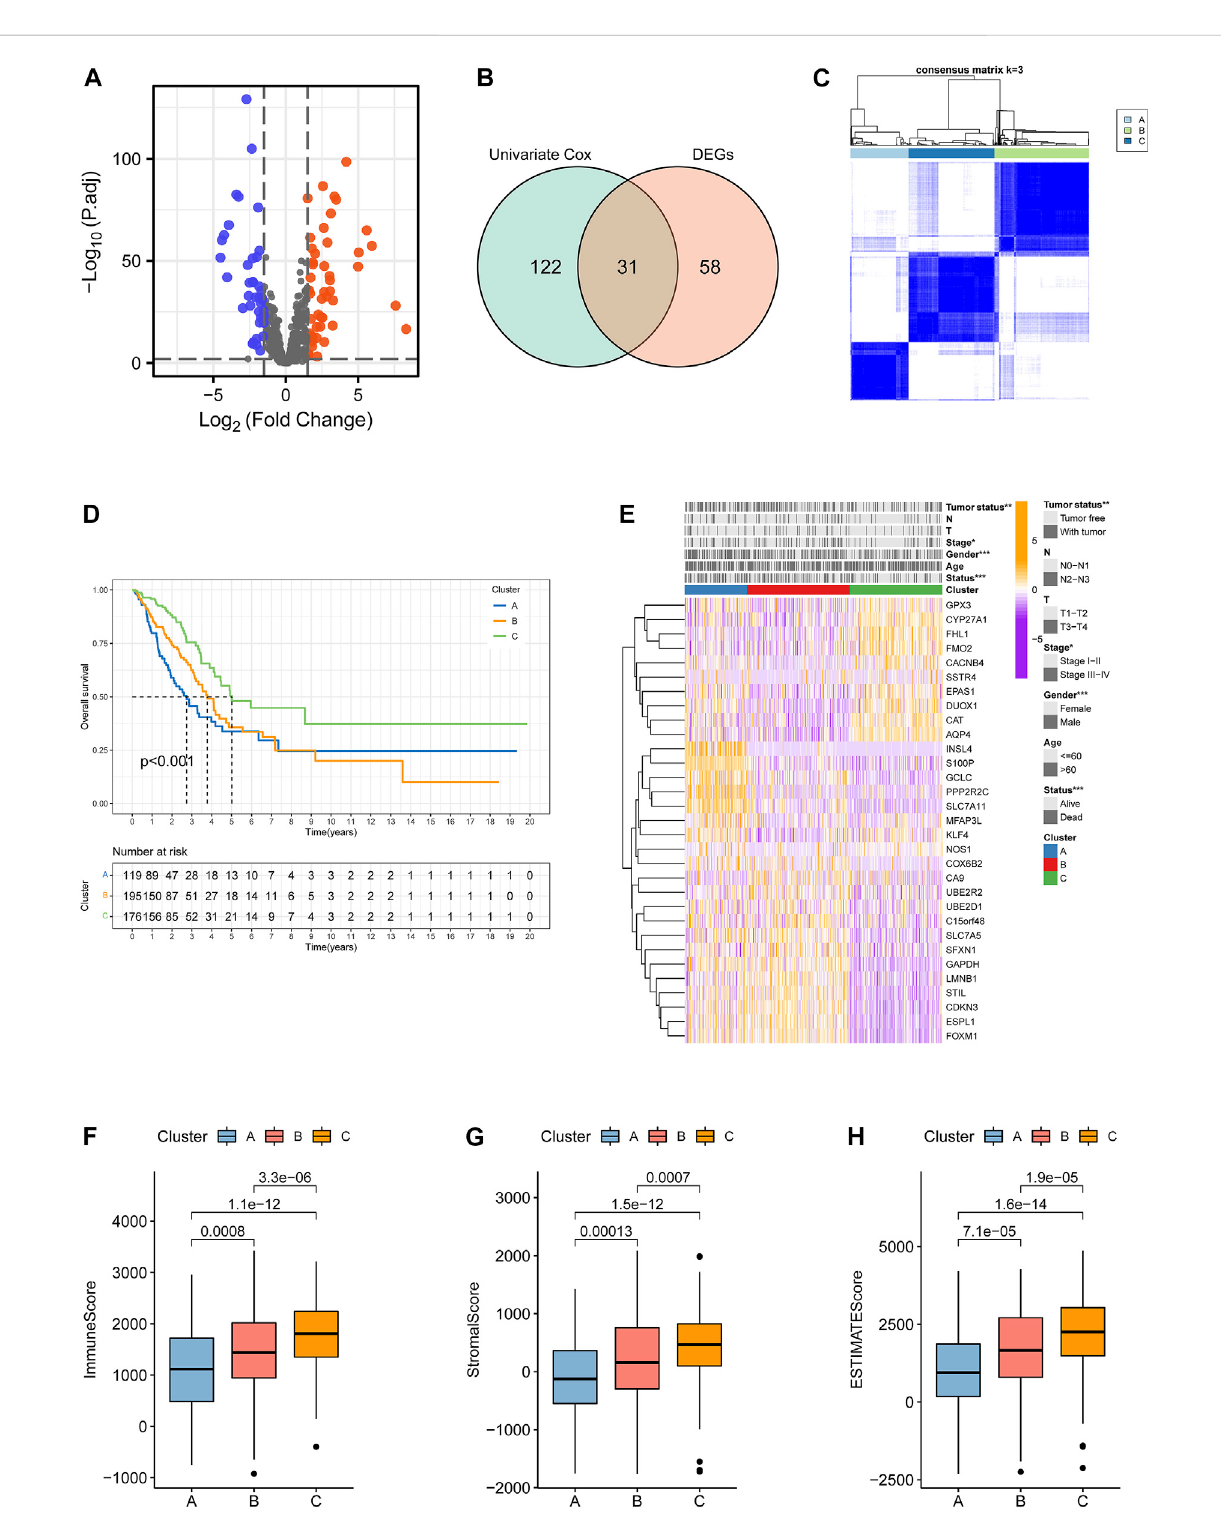
FIGURE 2 Identi fi cation of clustering subtypes based on prognostic differentially expressed ramRNAs. (A) Volcano plot with the thresholds of p < 0.01 and | log(Fold Change)| > 1.5. Blue points represented downregulated ramRNAs and red points represented upregulated ramRNAs in the tumor tissues compared with normal tissues. Gray points represented non-DEGs. (B) The 31 overlapped ramRNAs from univariate Cox regression and DEGs are shown by a Venn diagram. (C) Consensus matrix with 3 clustering subtypes. (D) Kaplan – Meier analysis and the log-rank test showed the signi fi cant differenceamongClustersA – C.Blackdottedlinesrepresentedthemediansurvivalofeachclustering. (E) TheHeatmapillustratedtheexpressionlevelsof 31 DEGs and clinicopathological variable distributions among the three clustering subtypes (*** p < 0.001, ** p < 0.01, and * p < 0.05). Orange indicates three high-expression levels, while purple indicates a low level. (F – H) Differences in immune, stromal, and ESTIMATE scores among the subtypes. ramRNA: redox-associated messenger RNA and DEG: differentially expressed